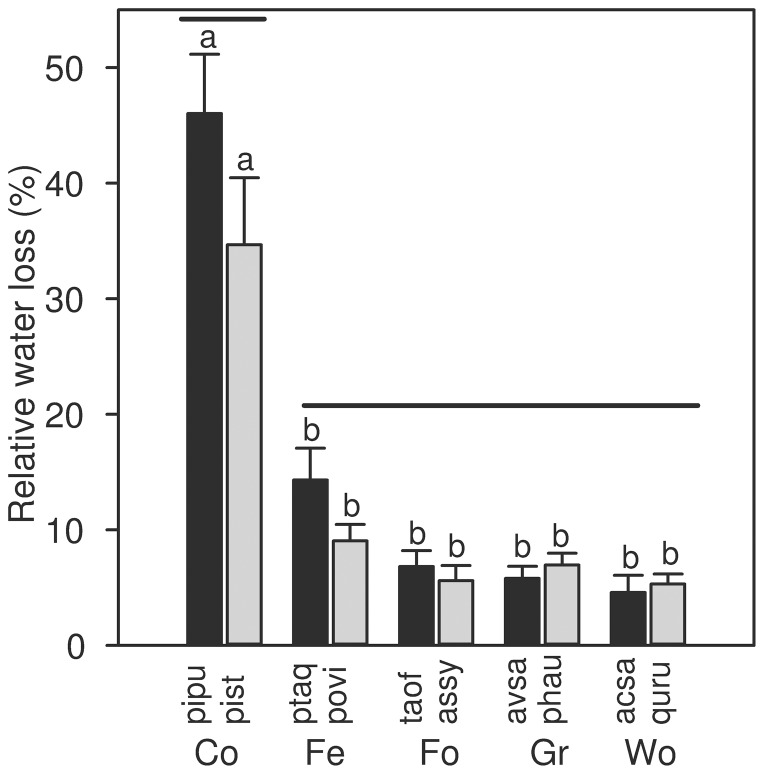
Water loss of the different growth forms and species after cold (2°C) storage.Different letters indicate significant differences within storage treatment (P≤0.05, n = 175 for ambient temperature storage, n = 225 for the other treatments). Growth forms not connected by solid bars are significantly different (P≤0.05). Abbreviations for growth forms are Co - conifer, Fe - fern, Fo - forb, Gr - graminoid, Wo - woody dicot. Abbreviations for species are given in Table 1. Error bars indicate 1 SE.